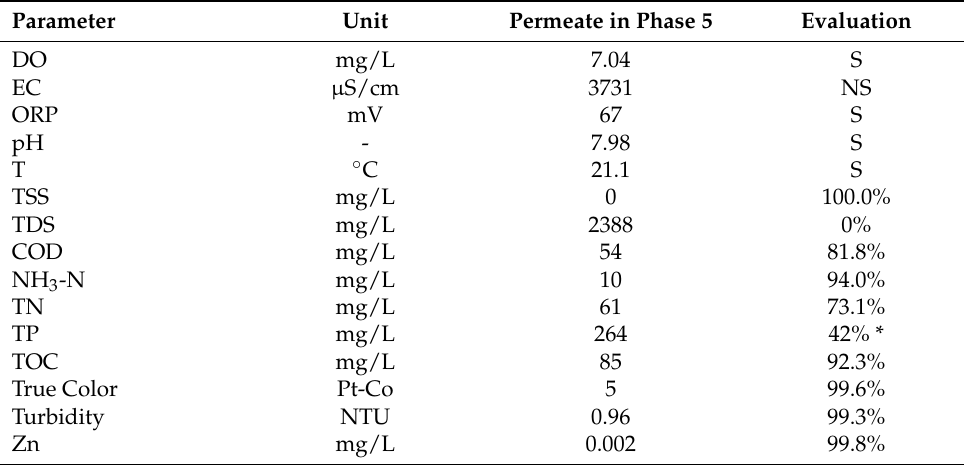
Table 8. Summary of final treated water quality using enhanced membrane bioreactor.